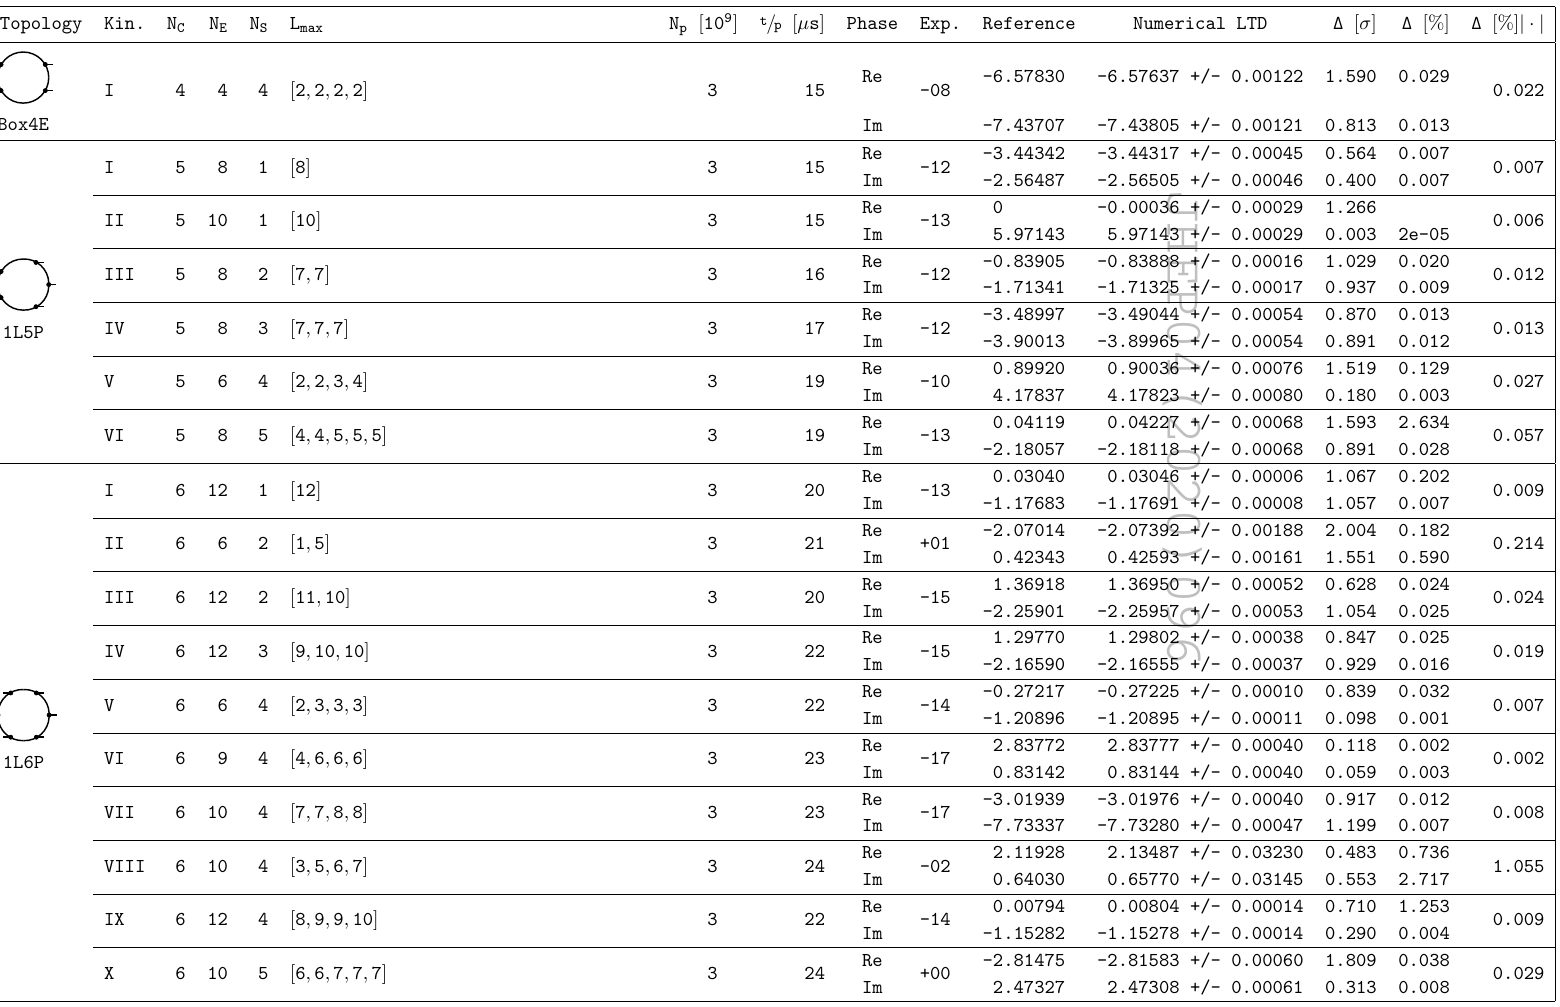
Table 1. Results for one-loop four-point to six-point functions. Box4E has been used as an example topology throughout this work. See the main text for